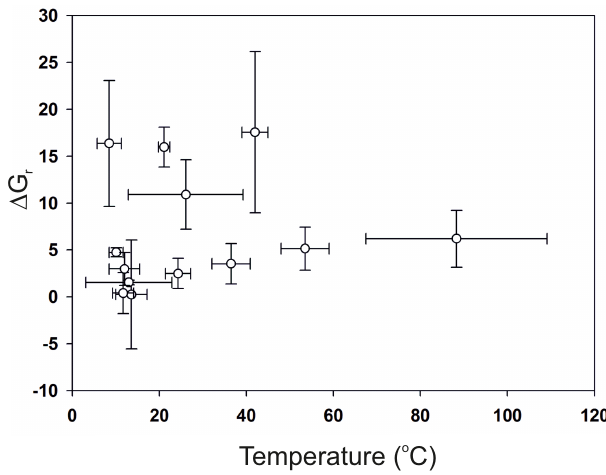
Figure 2. Summary of spontaneous nucleation index (dimension- less) and temperature ( ◦ C) from Table 2 (note logarithmic